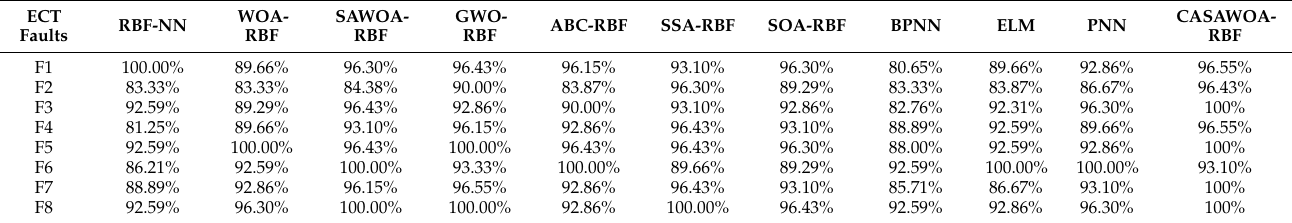
Table 12. Comparison of the recall for each